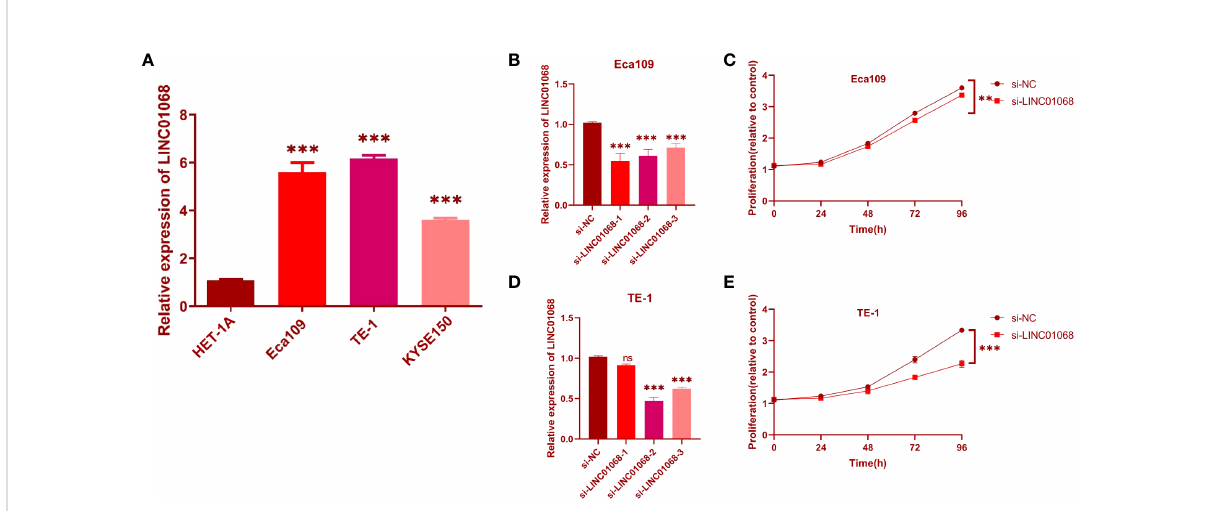
FIGURE 10 Effects of inhibiting the expression of LINC01068 on cell proliferation. (A) The upregulation of LINC01068 was displayed in Eca109, TE-1, and KYSE-150 cells compared to HET-1A based on qRT-PCR. (B, C) The expression of LINC01068 was downregulated in TE-1 and Eca109 cells by si-RNAs. (D, E) TE-1 and Eca109 cell proliferation after measuring anti-LINC01068 siRNA transfection with CCK-8 assays. ns, not signi fi cant, ** P < 0.01, *** P <